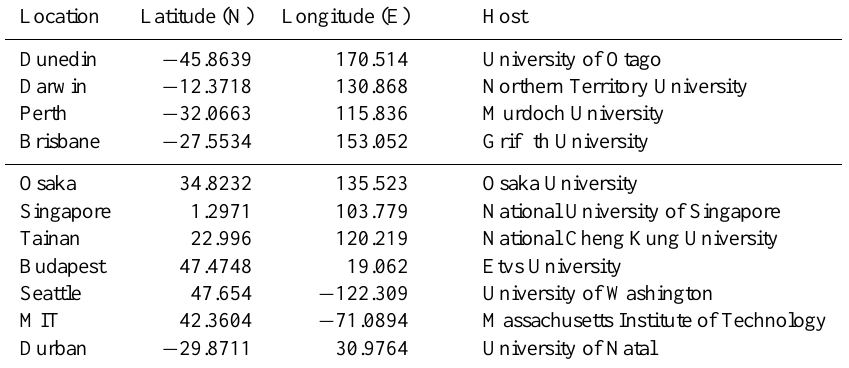
MIT 42.3604 − 71.0894 Durban − 29.8711